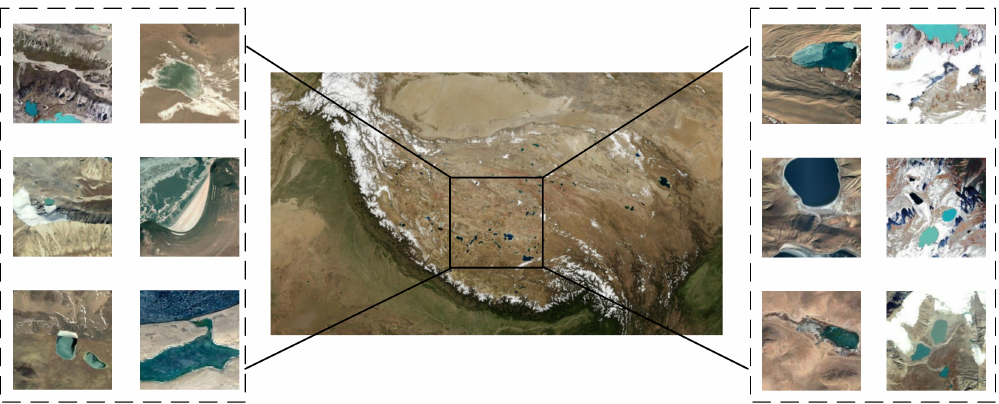
Figure 5. Sampling location of Qinghai–Tibet Plateau Lake dataset. Inside the dotted box are some typical samples.